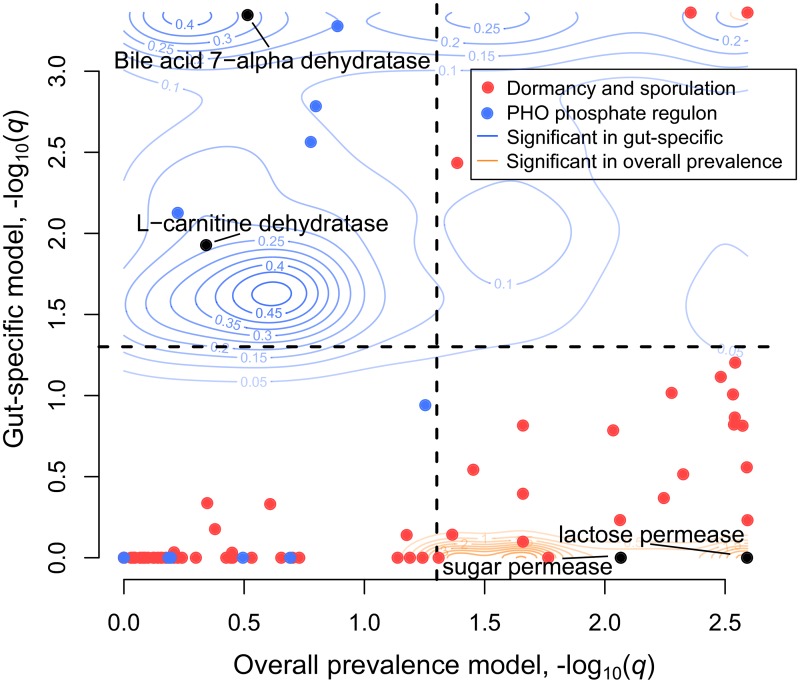
Comparison of results from the overall prevalence and body-site specific models for Firmicutes.FDR-corrected significance (as −log10(q)) of the overall model is plotted on the horizontal axis, whereas the same quantity for the body-site-specific model is plotted on the vertical axis. All FIGfams significant (q ≤ 0.05) in at least one of the two models are plotted as contour lines: FIGfams significant in the overall prevalence model (and possibly also the gut specific model) are plotted in orange, while FIGfams significant in the gut specific model (and possibly also the overall prevalence model) are plotted in blue. Selected SEED subsystems are displayed as colored points (legend), and selected individual genes are plotted as black points.